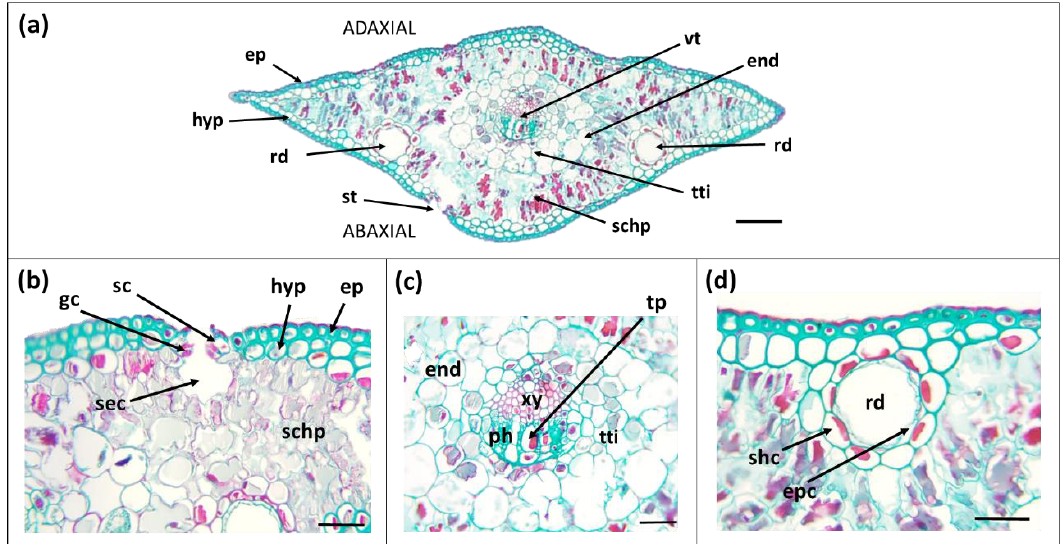
Figure 4. Stained cross-sections of Pinus canariensis primary (juvenile) needles. ( a ) Whole view of the needle cross-section. ( b ) Detail of the stomata and outer tissues of the needle. ( c ) Detail of the vascular bundle and all the conductive elements. ( d ) Detail of a resin duct. Abbreviations: end, endodermis; ep, epidermis; epc, epithelial cells; gc, guard cells; hyp, hypodermis; ph, phloem; rd, resin duct; sc, subsidiary cells; schp, spongy chlorophyll parenchyma; sec, substomatal chamber; shc, sheath cell; st, stomata; tp, transfusion parenchyma; tt, transfusion tracheid; tti, transfusion tissue; vt, vascular tissue; xy, xylem. Scale bars ( a ), 50 µm, ( b – d ), 20 µm. Safranin—fast green staining. Table 1. Morphological traits of secondary (adult) and primary (juvenile) needles in P. canariensis . Values are mean ± SE ( n = 20, except for leaf water content, dry weight/fresh weight (DW/FW) ratio and leaf mas area (LMA) where n = 9, and contact angle (CA) where n = 16–20). Values highlighted in bold with different letters depict significant differences be- tween secondary (adult) and primary (juvenile) needles ( p < 0.05).